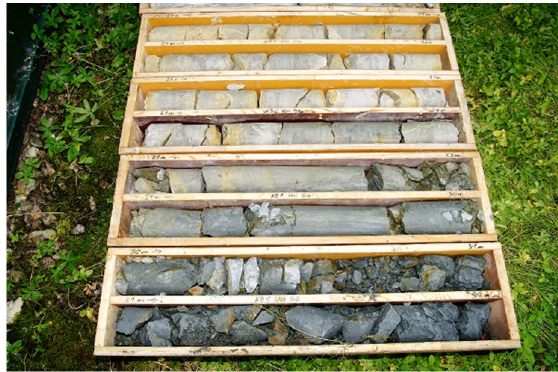
Figure 7. Rock samples of depth from 24 m to 31 m in well N.